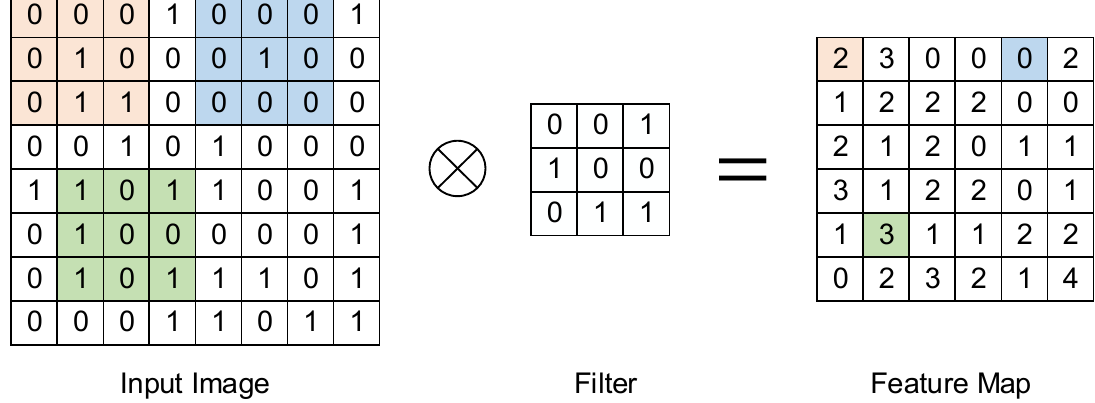
Figure 4. Diagram of operations performed by the convolutional layer.